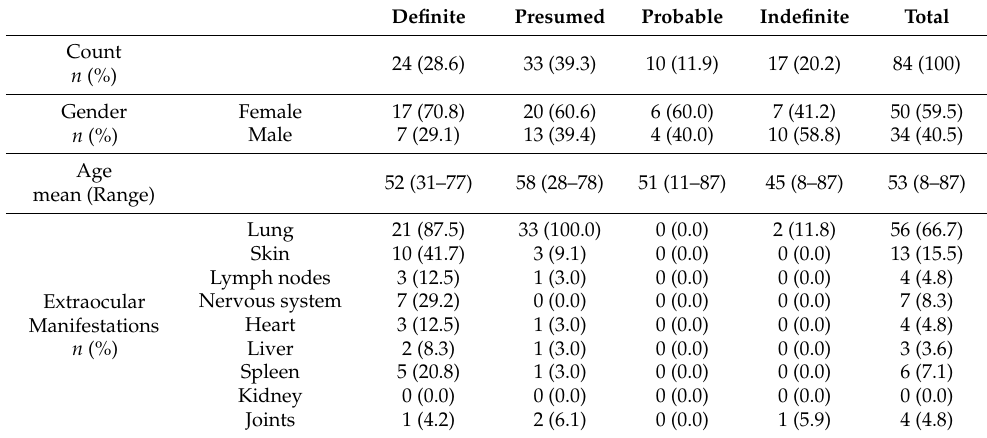
Table 3. Patient characteristics and sarcoid